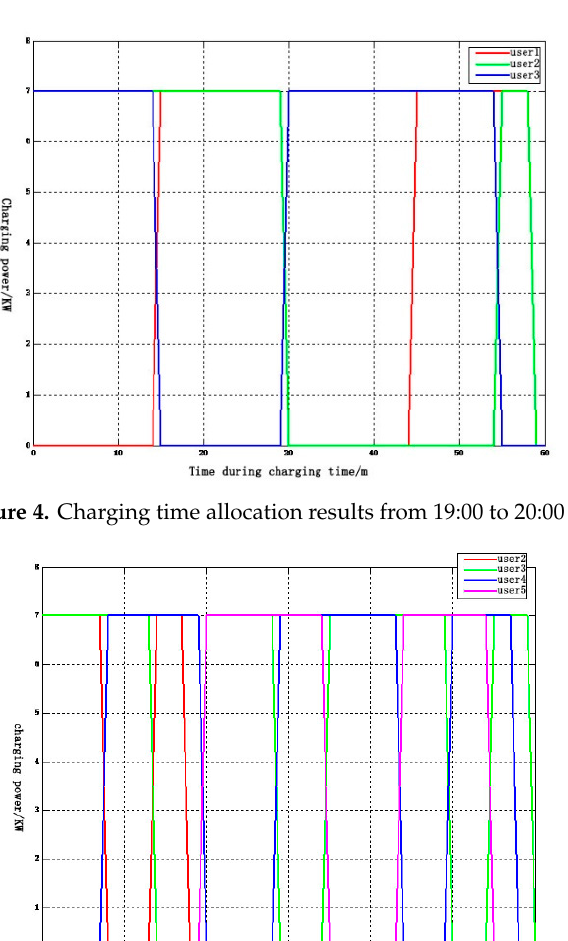
Figure 3. User points bid graph.